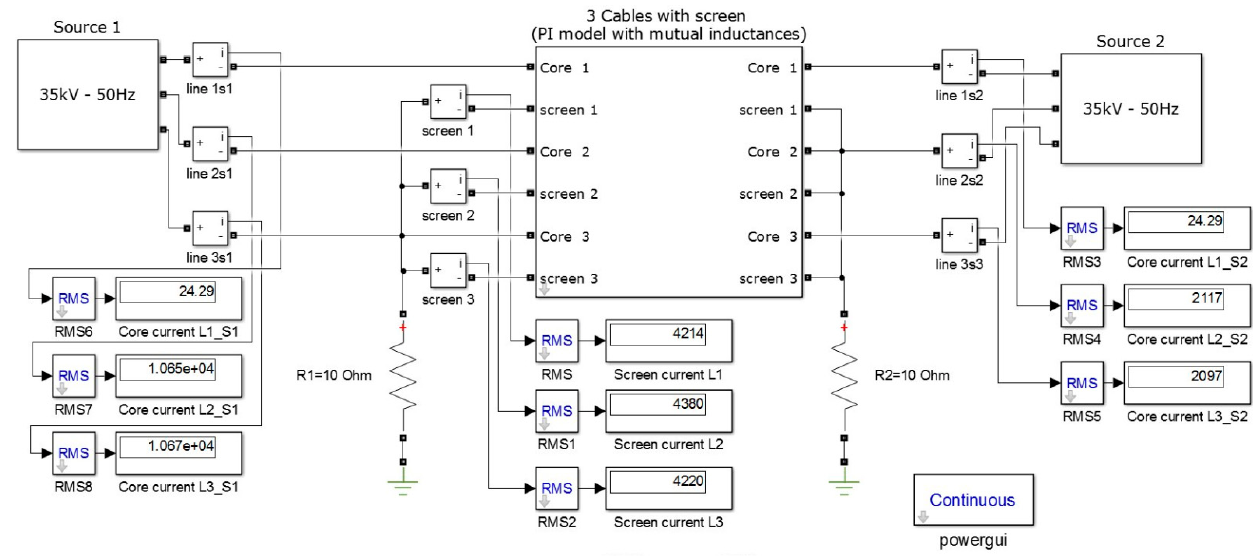
Figure 5. Model in MATLAB Simulink for calculating the current through the cables screen during a double line-to-earth fault in the case of cable lines laid with single-core cables in which the screens are grounded on both sides and taking into account two energy sources.